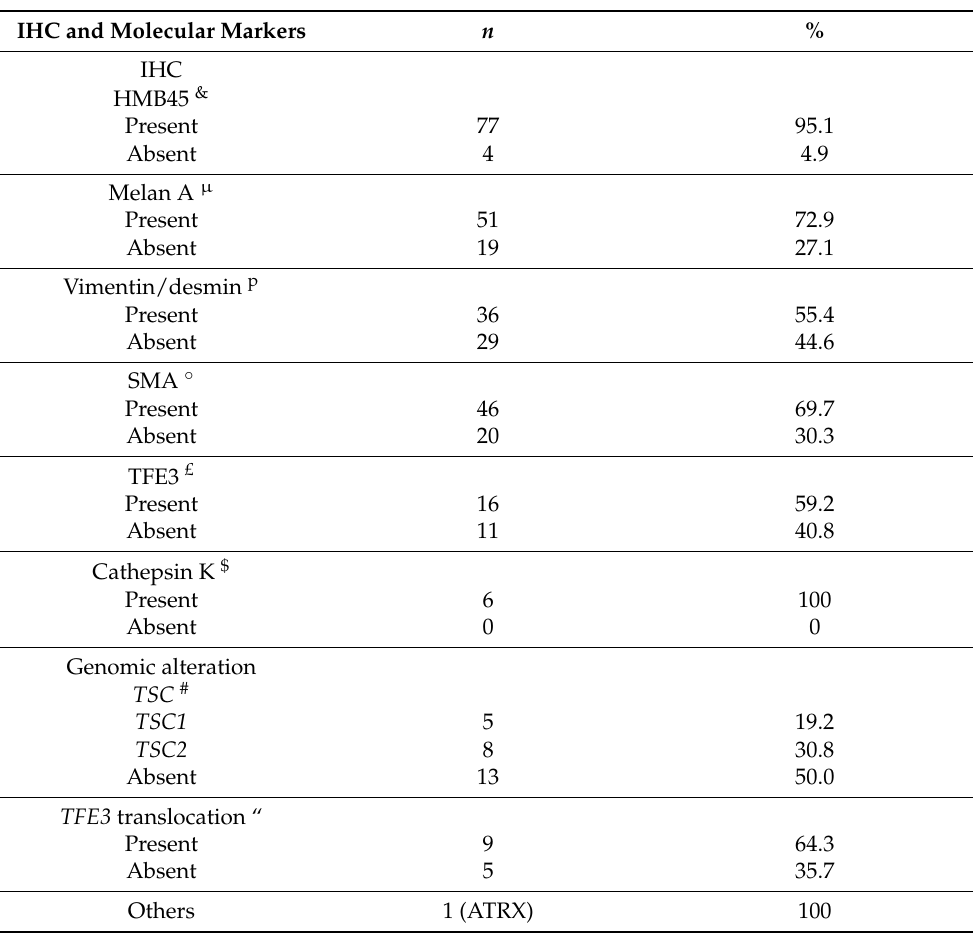
Table 4. Immunohistochemistry profile and major genomic alterations from individual case reports ( N =